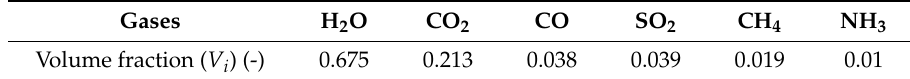
Table 4. Average volume fraction of main gas released when T700/M21 is exposed to controlled radiative heat flux of 50 kW/m² under nitrogen atmosphere.